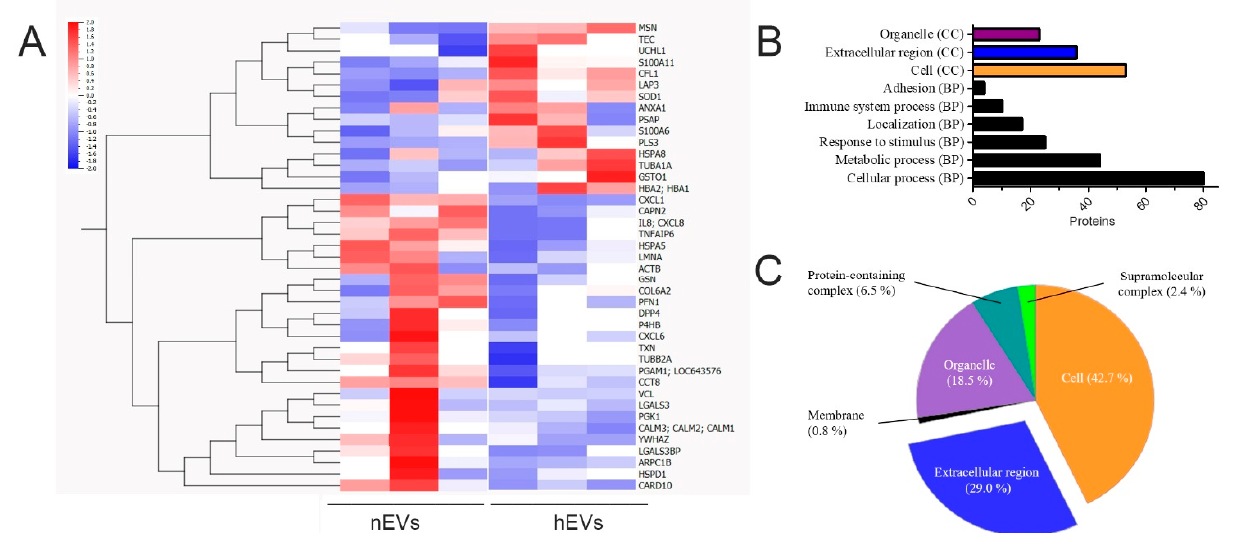
Figure 3. Analysis of proteomics. Six selected protein samples from EV isolations (3 nEVs versus 3 hEVs samples) were used to perform proteomic analysis via mass spectrometry. ( A ) Heatmap with hierarchical clustering. Forty-one human proteins were detected with different cargos between nEVs and hEVs (either >1.5 or <0.6 in the ratio hEVs/nEVs). ( B , C ) Proteomic analysis of hEVs. ( B ) Bar chart displaying the number of proteins that cluster for selected gene ontology (GO) terms for the cellular component (CC) and biological process (BP). ( C ) Pie chart showing the percentage of detected proteins that cluster for indicated cellular components (CC GO terms).